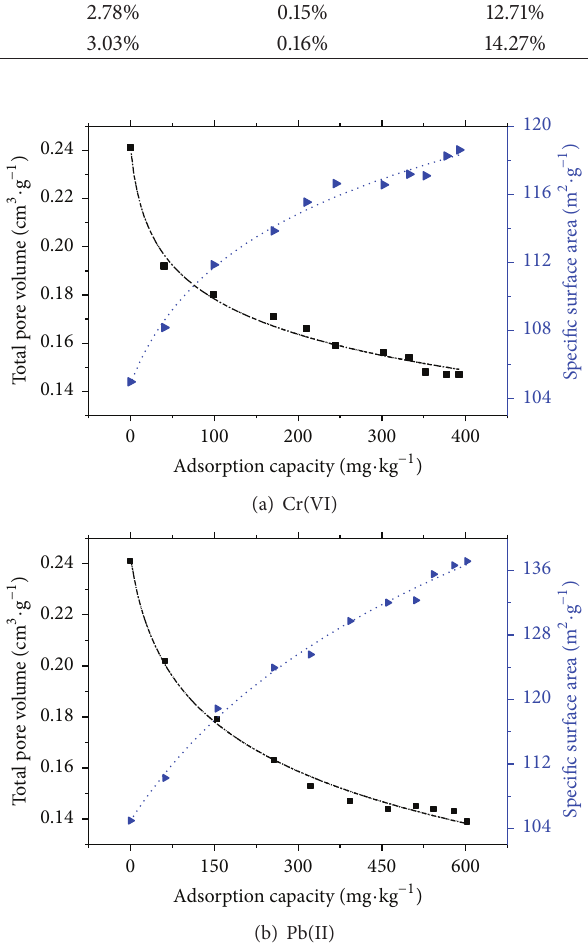
Figure 9: Adsorption equilibrium concentration and parameter variation curve of pore